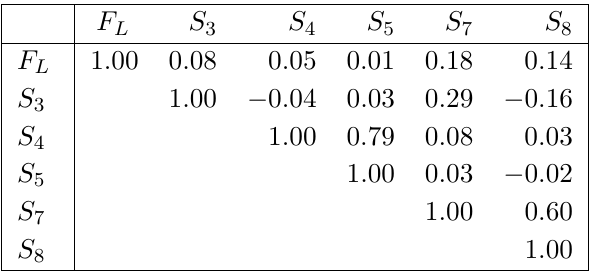
and S parameters obtained for q 2 2 L